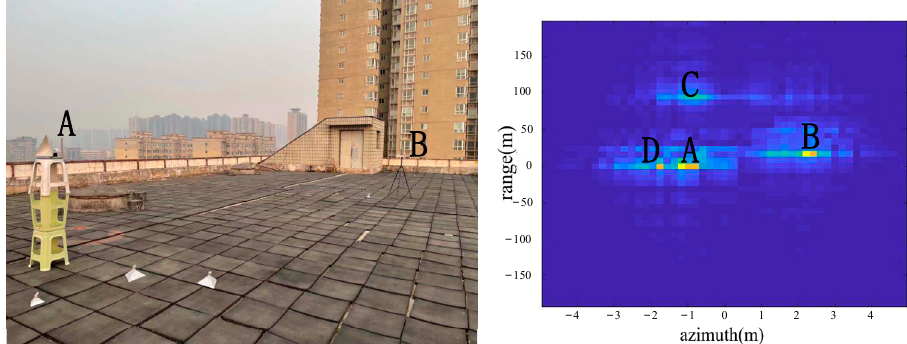
Figure 12. The 7th group of experimental scenes and imaging results.